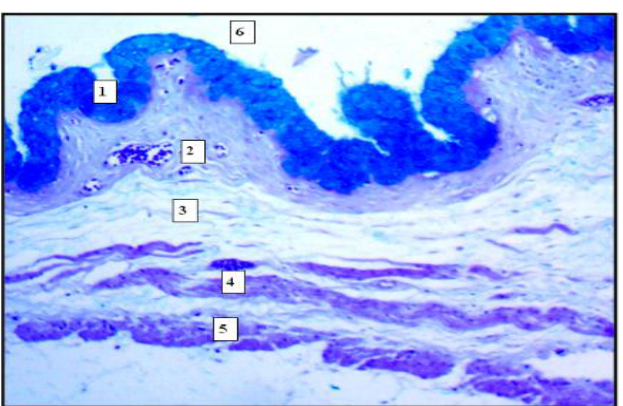
Figure 9. Vagina at its middle region showing short mucosal folds (1) covered with simple columnar mucous epithelium positively stained with Alcian blue, propria – submucosa (2& 3), internal circular layer (4) and external longitudinal (5) layers of tunica muscularis, vaginal lumen (6). 100X, Alcian blue stain